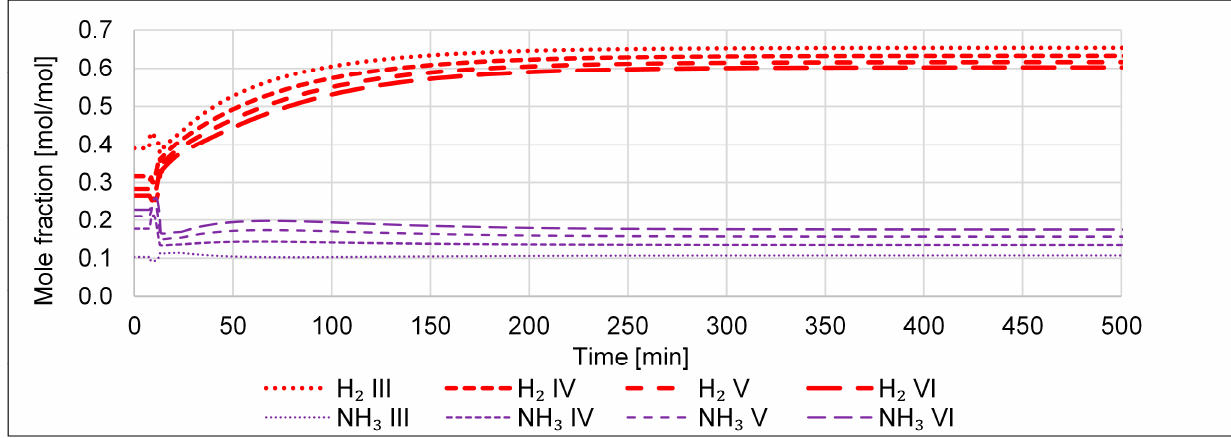
Figure 28 . Selected mole fractions of scenario (j). Figure 28. Selected mole fractions of scenario (j).